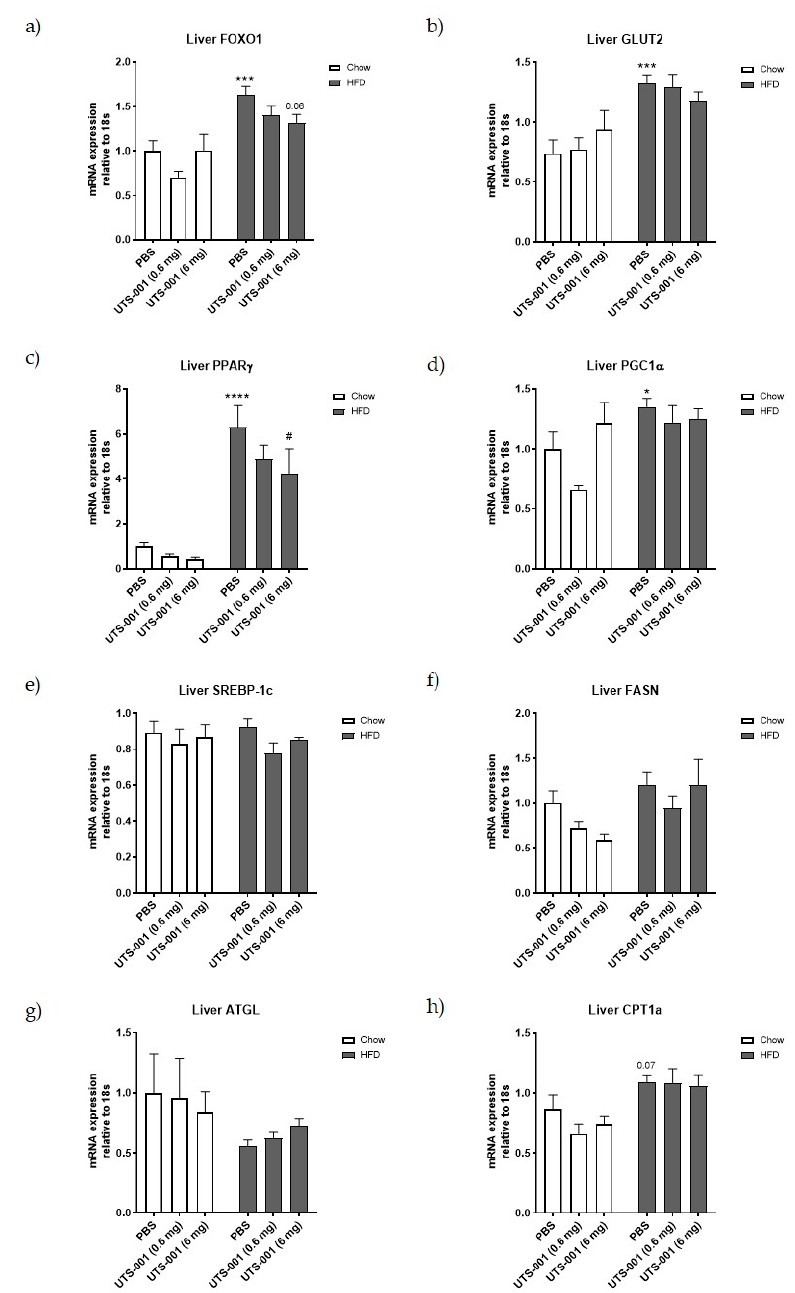
Figure 4. mRNA expression of liver glucose and lipids markers ( a ) FOXO-1, ( b ) GLUT-2, ( c ) PPAR γ , ( d )